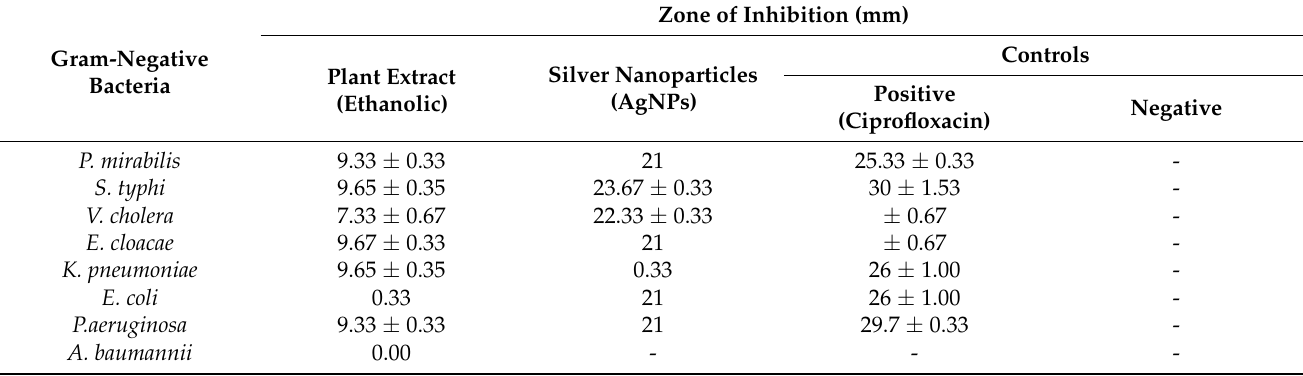
Table 2. Antimicrobial activity of ethanolic extract of S. mombin and AgNP synthesized with ethanolic extract of S. mombin against Gram-negative bacteria. The information presented in the table with the mean ( ± SE, standard error), p < 0.05.